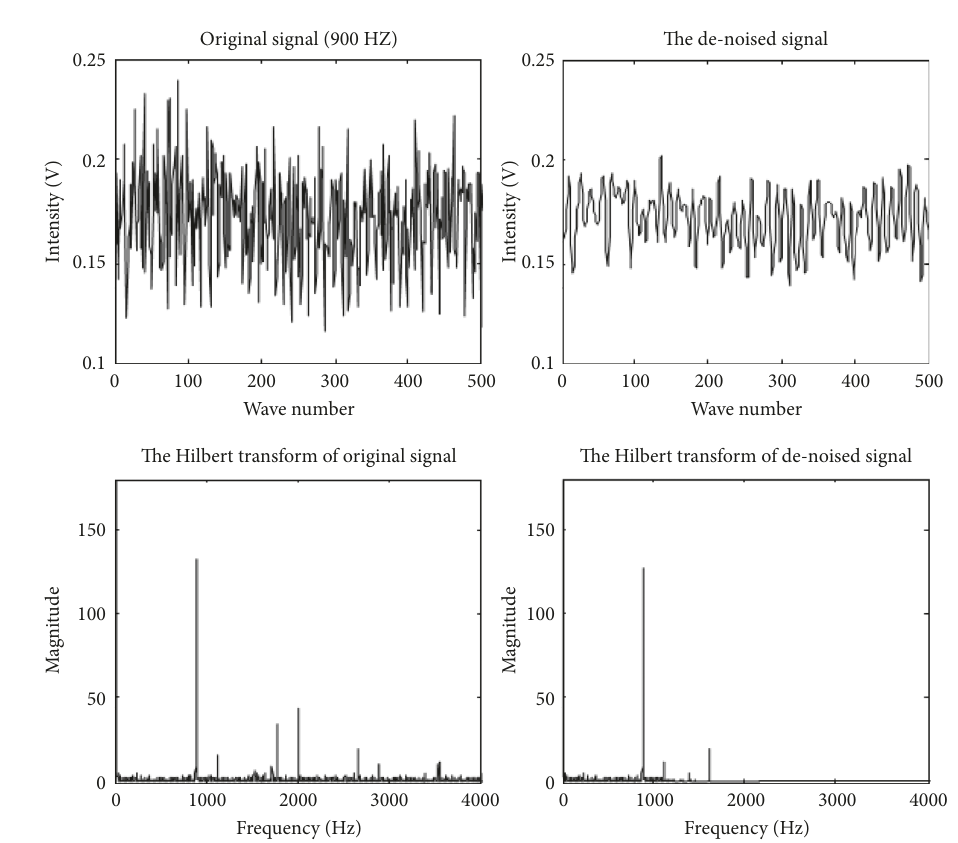
Figure 9: Comparison diagram of original signal and signal and spectrum after wavelet packet decomposition and noise reduction under 900Hz sine wave